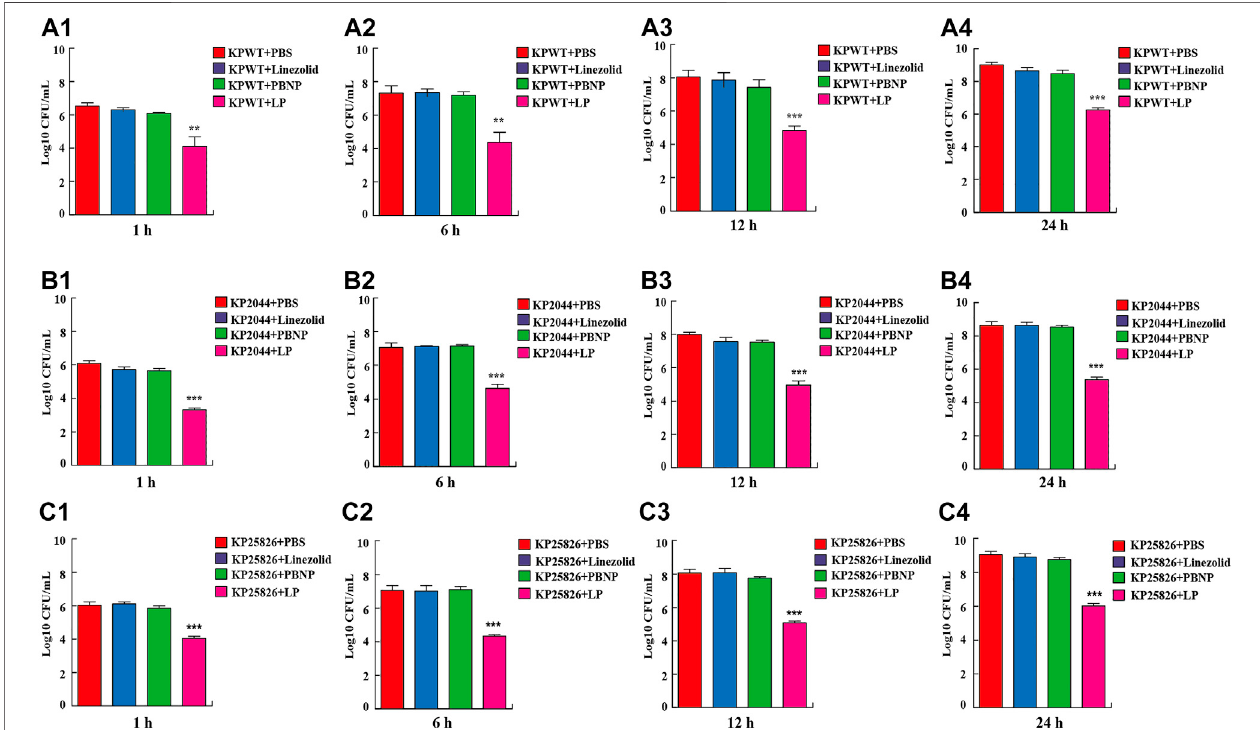
FIGURE1| TreatmentofLP reduced K.pneumoniae viability (A1 – A4) 1× 10 5 CFU ofKPWTwere seeded in96-well plates and treatedwith PBS,linezolid(16 μ g/ ml), PBNP (8 μ g/ml) or combination of linezolid and PBNP (LP) for 1 h (A1) , 6 h (A2) , 12 h (A3) , and 24 h (A4) , respectively. The bacteria on the LB agar plates were counted. (B1 – B4) 1 × 10 5 CFU of KP2044 were seeded in 96-well plates and treated with PBS, linezolid (16 μ g/ml), PBNP (8 μ g/ml) or LP for 1 h (B1) , 6 h (B2) , 12 h (B3) ,and24 h (B4) . (C1 – C4) 1×10 5 CFUofKP25826wereseededin96-wellplatesandtreatedwithPBS,linezolid(16 μ g/ml),PBNP(8 μ g/ml)orLPfor1 h (C1) , 6 h (C2) , 12 h (C3) , and 24 h (C4) . The bacteria were determined as described above. Data are shown as the mean ± SEM of three independent experiments. *** p < 0.001, ** p <